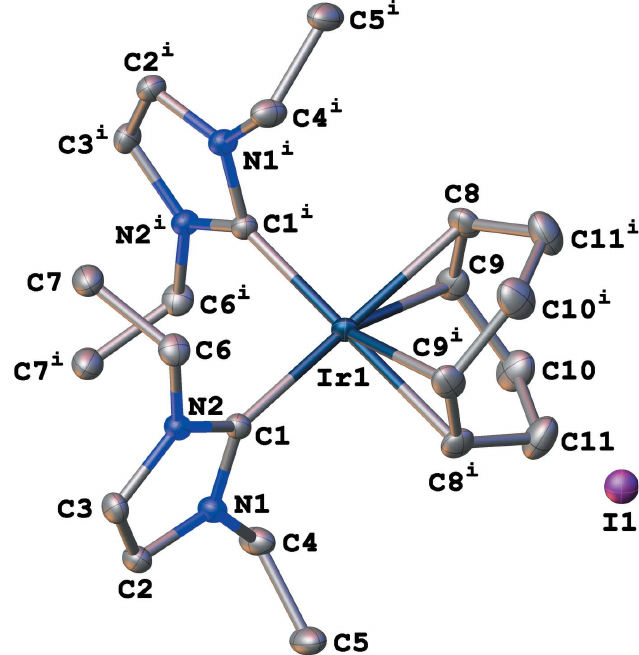
Figure 3 Displacement ellipsoid plot (50% probability) of ( (cid:2) 4 -cycloocta-1,5-